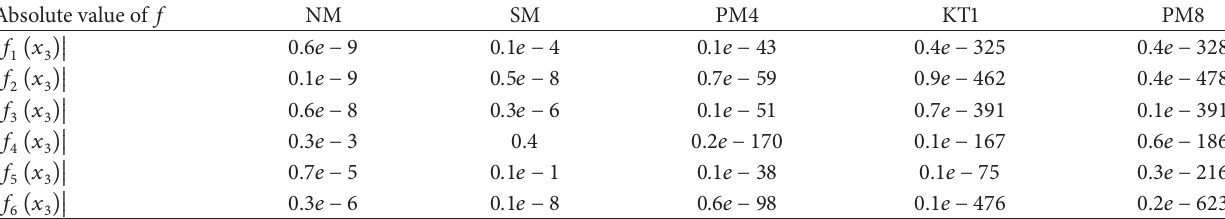
Table 2: Results of comparisons for different methods after three